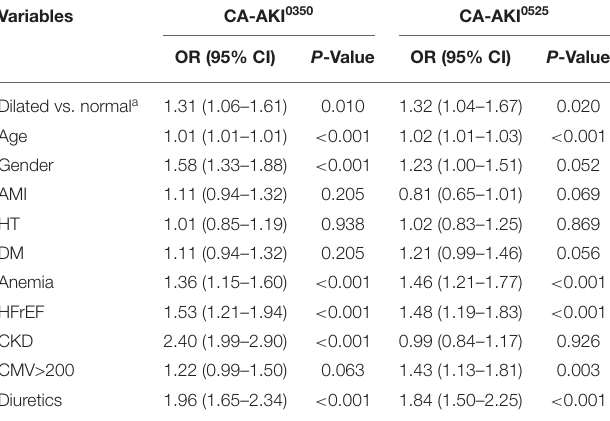
TABLE 3 | Multivariable regression analysis of CA-AKI in different